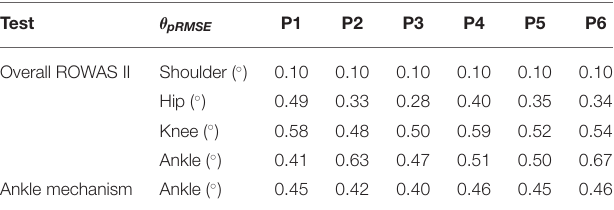
TABLE 2 | RMSE values of all participants using the ROWAS II system running in passive mode.